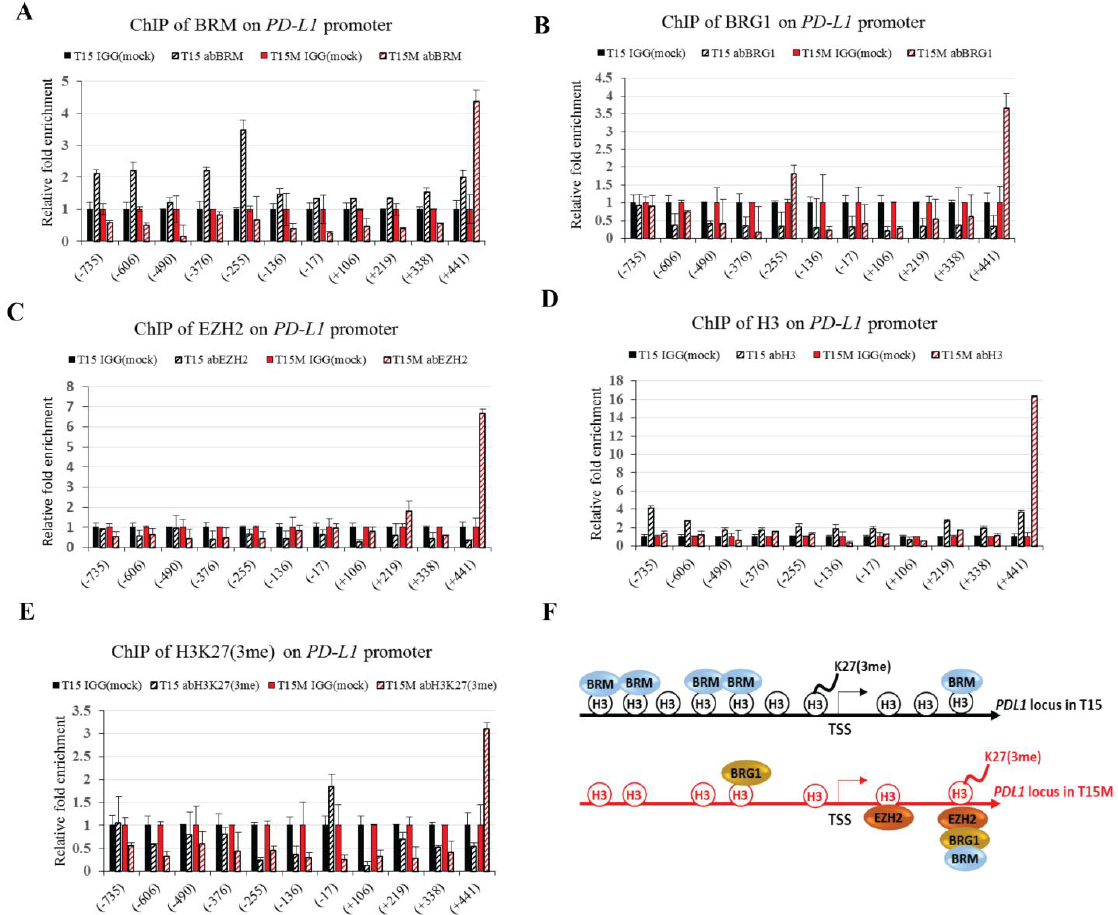
Figure 6. The chromatin status of the PD-L1 locus varies upon CD4 + T cell exhaustion: ( A ) the presence of BRM ATPase of SWI/SNF CRCs on the PD-L1 locus; ( B ) the presence of BRG1 ATPase of SWI/SNF CRCs on the PD-L1 locus; ( C ) the presence of the EZH2 subunit of PRC2 on the PD-L1 locus; ( D ) the presence of histone 3 (H3) on the PD-L1 locus; ( E ) the presence of histone 3 lysine 27 trimethylation (H3K27me3) on the PD-L1 locus; ( F ) model describing chromatin status on the PD-L1 locus during exhaustion of CD4 + T cells. T15; CD4 + T cells restimulated for three days; T15M; CD4 + T cells restimulated in co-culture with cancer cells for 3 days. The experiment was repeated 3 times.